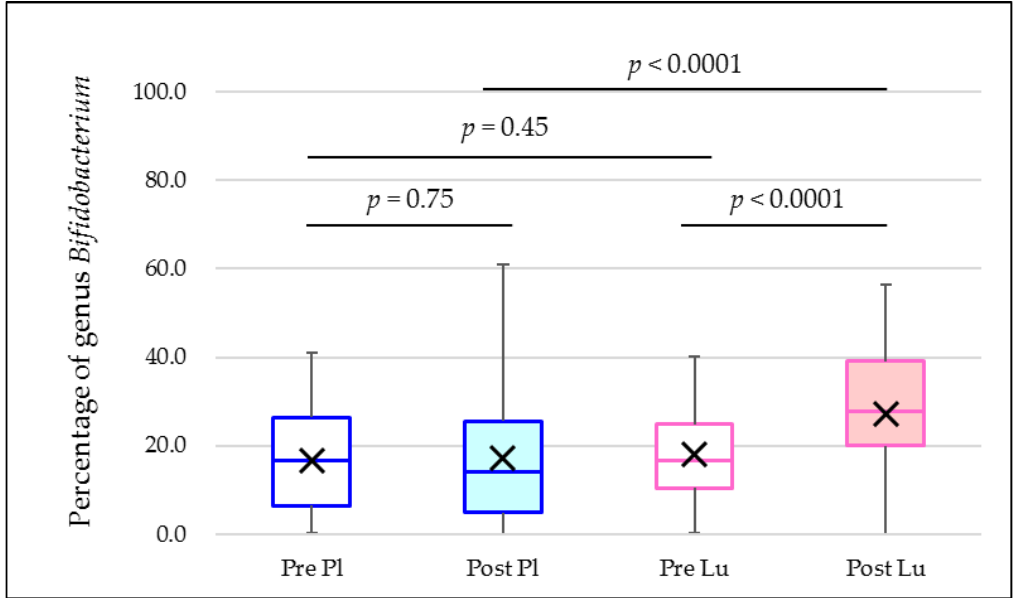
Figure A2. Comparison of the percentages of genus Bifidobacterium in faecal microbiota before intervention and after 2 weeks of intervention. Values are expressed as means (crosses) and quartiles. Pl, placebo; Lu, lactulose. p -values are for Pre Pl vs. Post Pl, Pre Lu vs. Post Lu, Pre Pl vs. Pre Lu, and Post Pl vs. Post Lu (paired t -test).